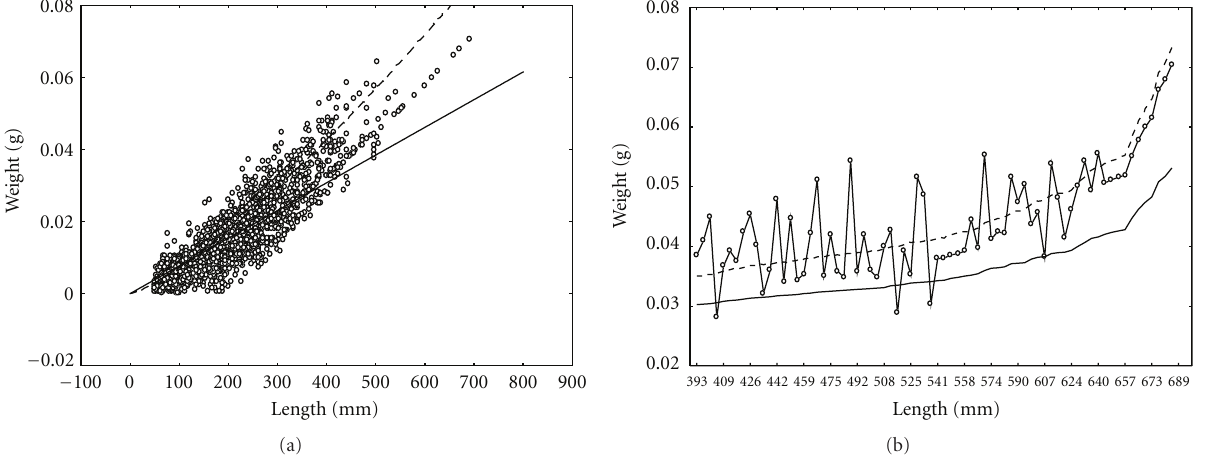
Figure 4: (a) Spread of raw data and plots produced by the fitted allometric (dashed lines) and isometric (continuous lines) models. (b) Subset of data containing leaf length values from 390 mm to 690